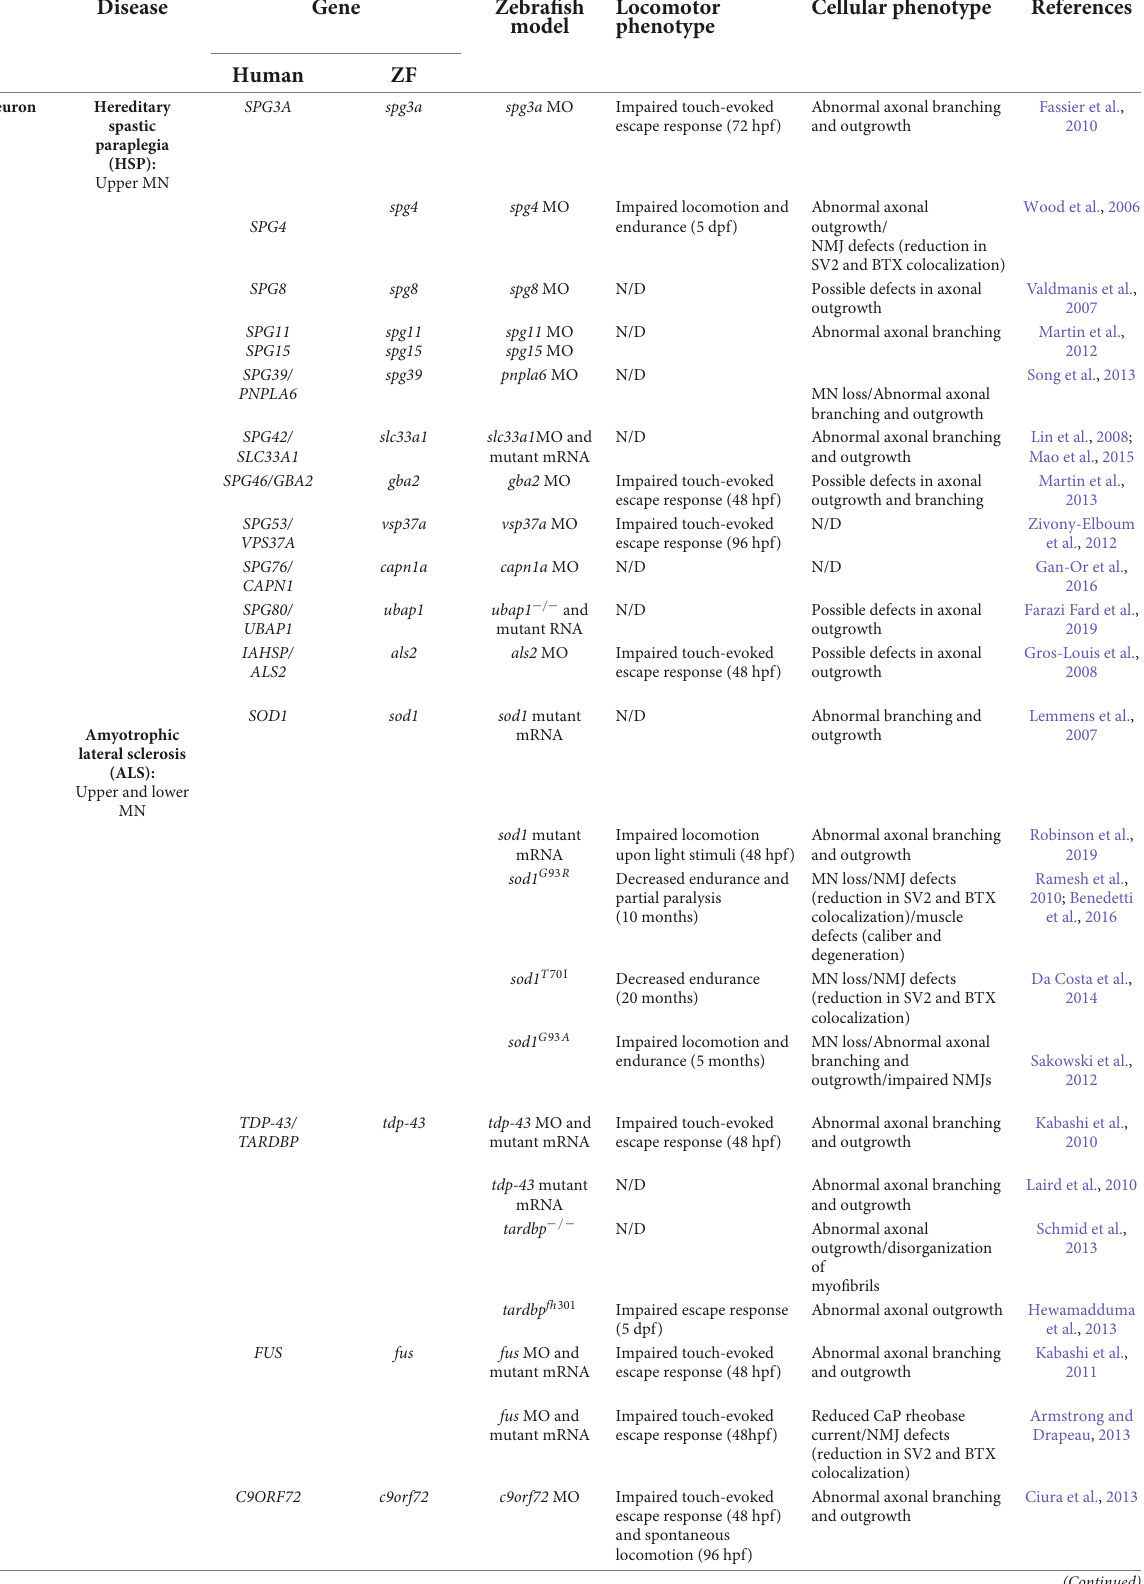
TABLE 1 Zebrafish models of NMDs and their distinct behavioral and cellular